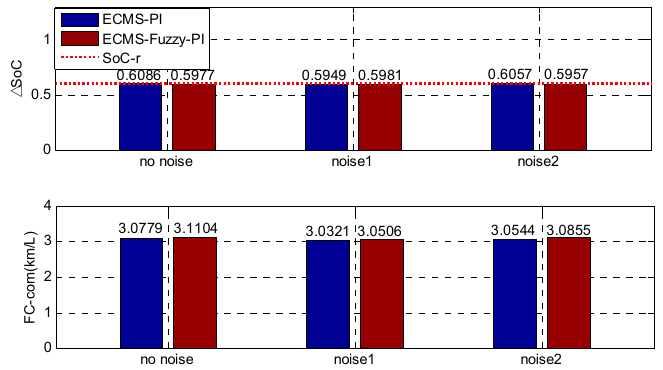
Figure 26. Comparison of ECMS-Fuzzy-PI and ECMS-PI. Note: SoC -r: SoC reference value.